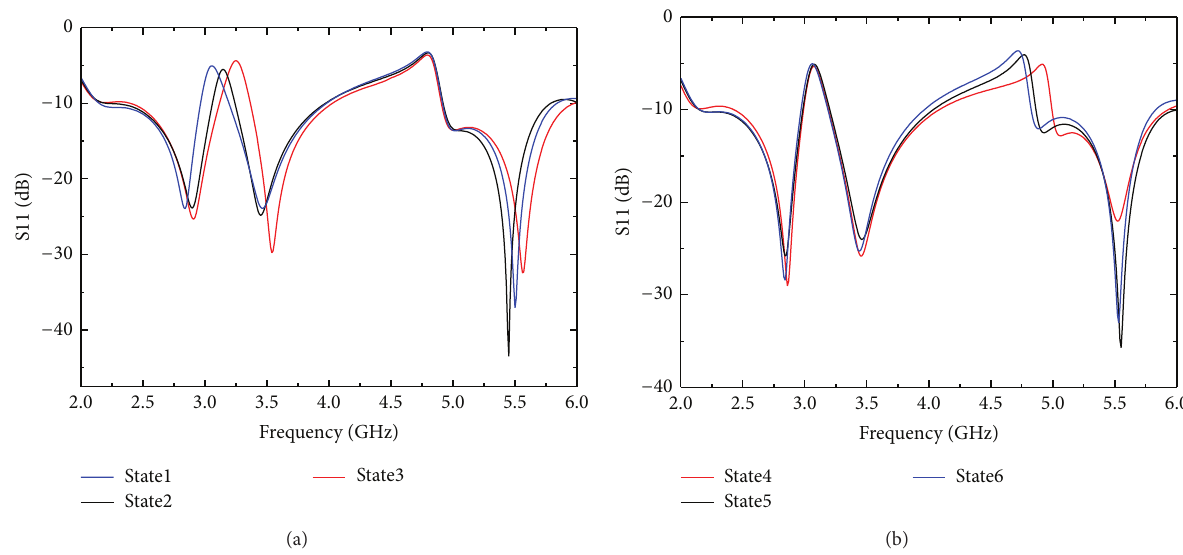
Figure 10: (a) Simulated results of the band-rejected feature against various lengths for slot 𝑠1 (state1: 𝐿1 = 10mm, 𝐿4 = 8.7 mm; state2: 𝐿1 = 10mm, 𝐿4 = 6.9 mm; state3: 𝐿1 = 9mm, 𝐿4 = 6.9 mm). (b) Simulated results of the band-rejected feature against various lengths for slot 𝑠2 (state4: 𝐿7 = 7.5mm; state5: 𝐿7 = 8.5 mm; state6: 𝐿7 = 8.5 mm).